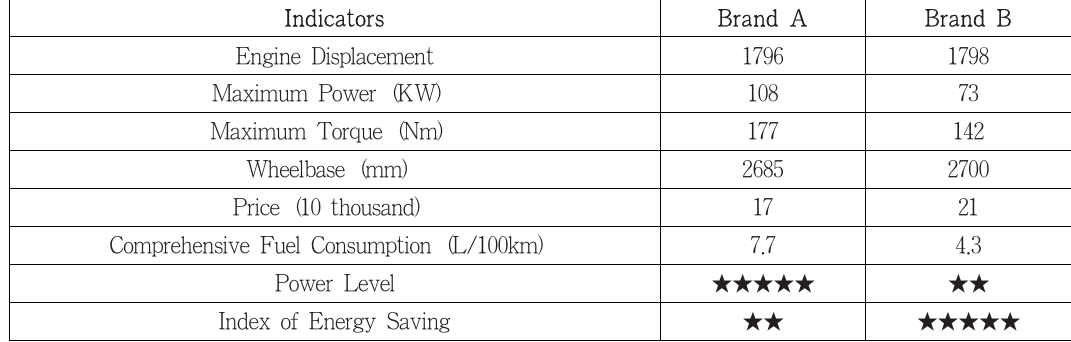
<Table 2> Manipulation readings on ecological